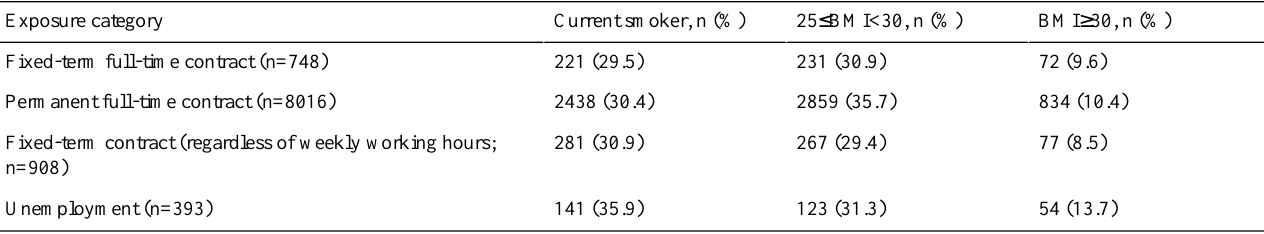
Table 5. Crude percentages of current smokers, people with moderate overweight (25 ≤ BMI<30), and people with obesity (BMI ≥ 30), by exposure category, in a random sample of 20- to 59-year-old people in Denmark, 2005.